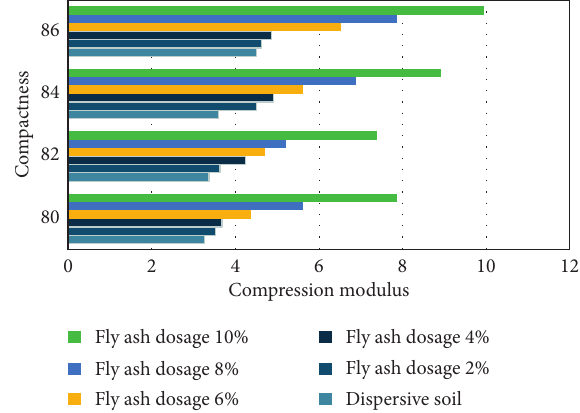
Figure 5: The relationship between compression modulus and